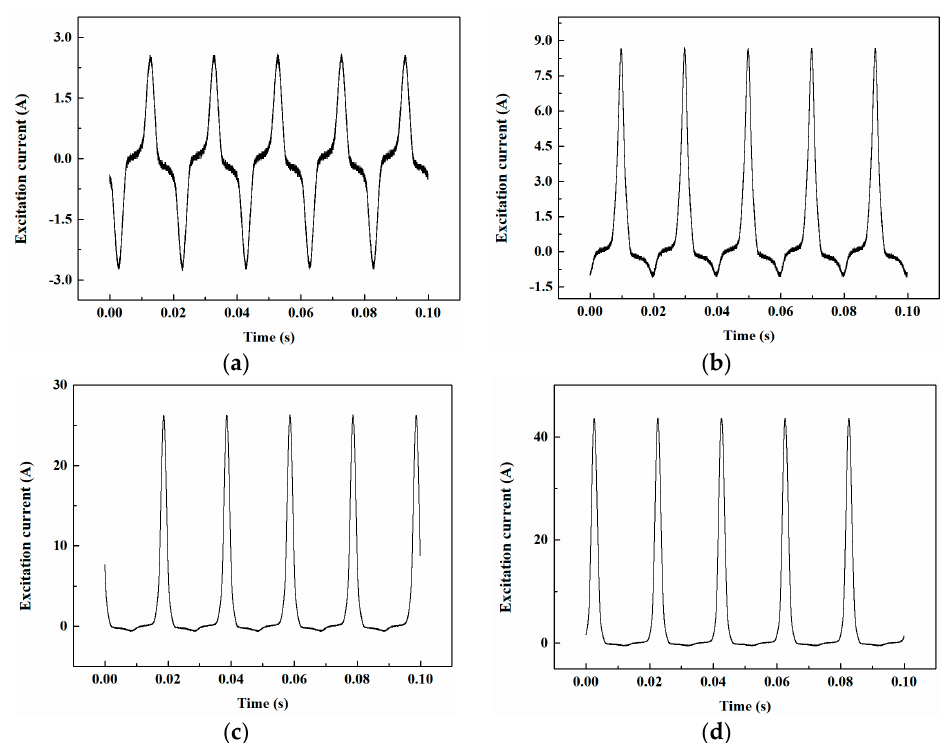
Figure 9. No-load excitation current waveform with and without DC bias current. ( a ) without DC bias current. ( b ) under 1 A DC bias current. ( c ) under 3 A DC bias current. ( d ) under 5 A DC bias current.